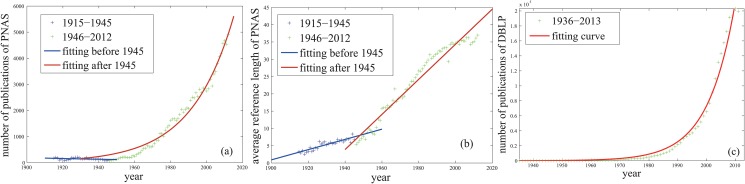
The evolutionary trends of the annual paper number and the annual average reference length of some datasets.The fitting curves for the data between 1946–2012 in Panels(a, b) are f(t) = 5.397 × 10−34e4.23 × 10−2t (R
2: 0.974, RMSE: 224.2) and f(t) = 0.5085t − 982.6 (R
2: 0.958, RMSE: 2.112) respectively. The fitting curve in Panel(c) is f(t) = 6.038 × 10−88e0.106t (R
2: 0.9828, RMSE: 7249).